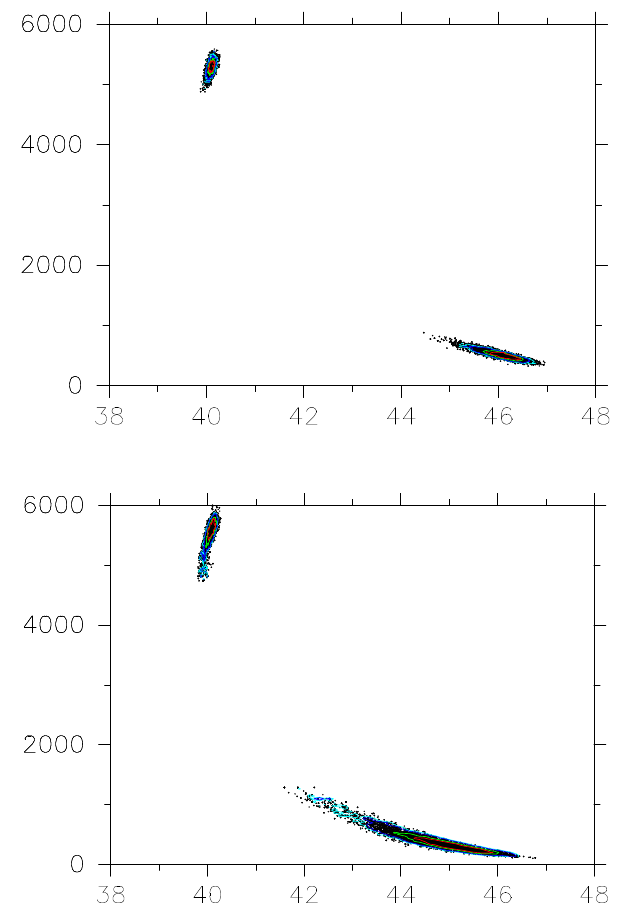
Figure 3. Two examples of the posteriori distributions of the ampli- tudes and positions. The two simulated Gaussian peaks have Pois- son noise added to each point. The Gaussians have a FWHM of 2.5 time-of-flight bins or 0.031 u at mass 100 u . Both test cases have a peak with an amplitude of 1000 and a second an amplitude of 100. Total bin counts are 5250 and 525, respectively. In the first case, the peaks are separated by six bins and in the second simulation by four bins, respectively. The red curve contains 50% posteriori con- fidence limits, the green curve 68%, the dark blue 90% and the light blue 95% limits. Note that the distribution maxima are well defined and close to the initial values. Note that the distributions have low density tails that reflect the fact that there is mild degeneracy in the solution. These kinds of distributions are not found trivially by con- ventional analysis